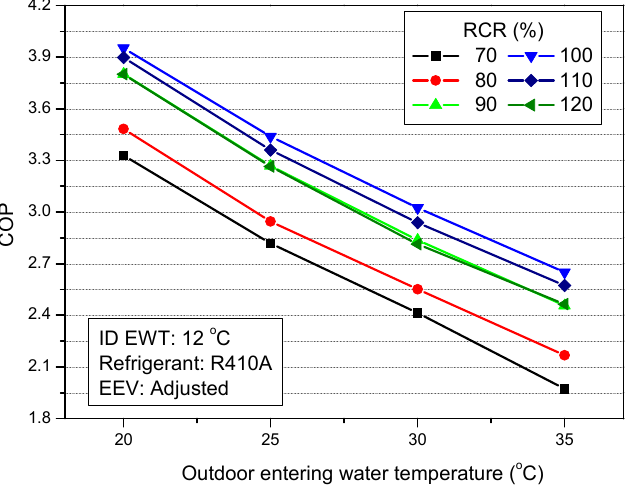
Figure 11. Variation of COP with T OD in cooling mode.